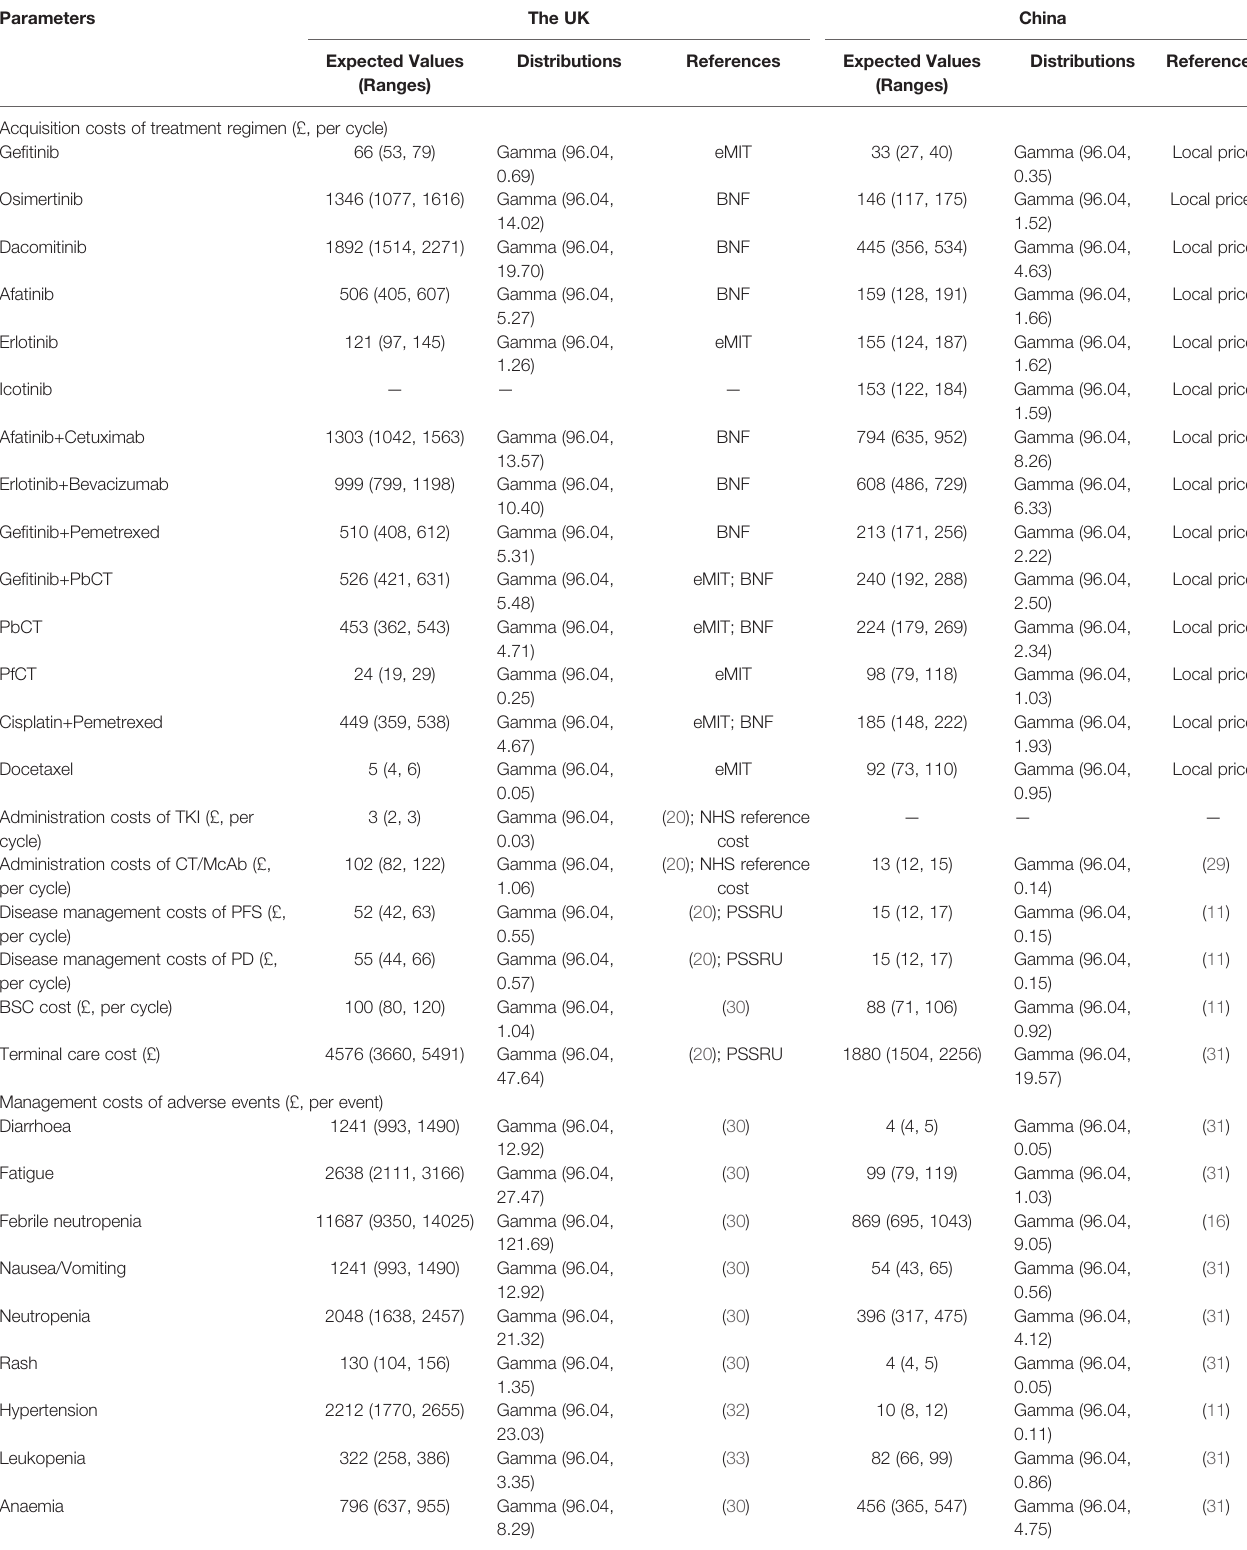
TABLE 2 | Key cost and utility